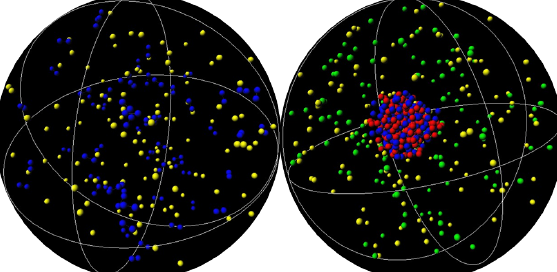
Figure 5. Representative snapshots showing 60 protein dimers (blue) and respective counterions (yellow) in the absence (left-hand side) and presence (right-hand side) of DNA (red) and respective counterions (green). It is clearly seen that the presence of DNA induces the association of the model H-NS proteins. ε pp = 2